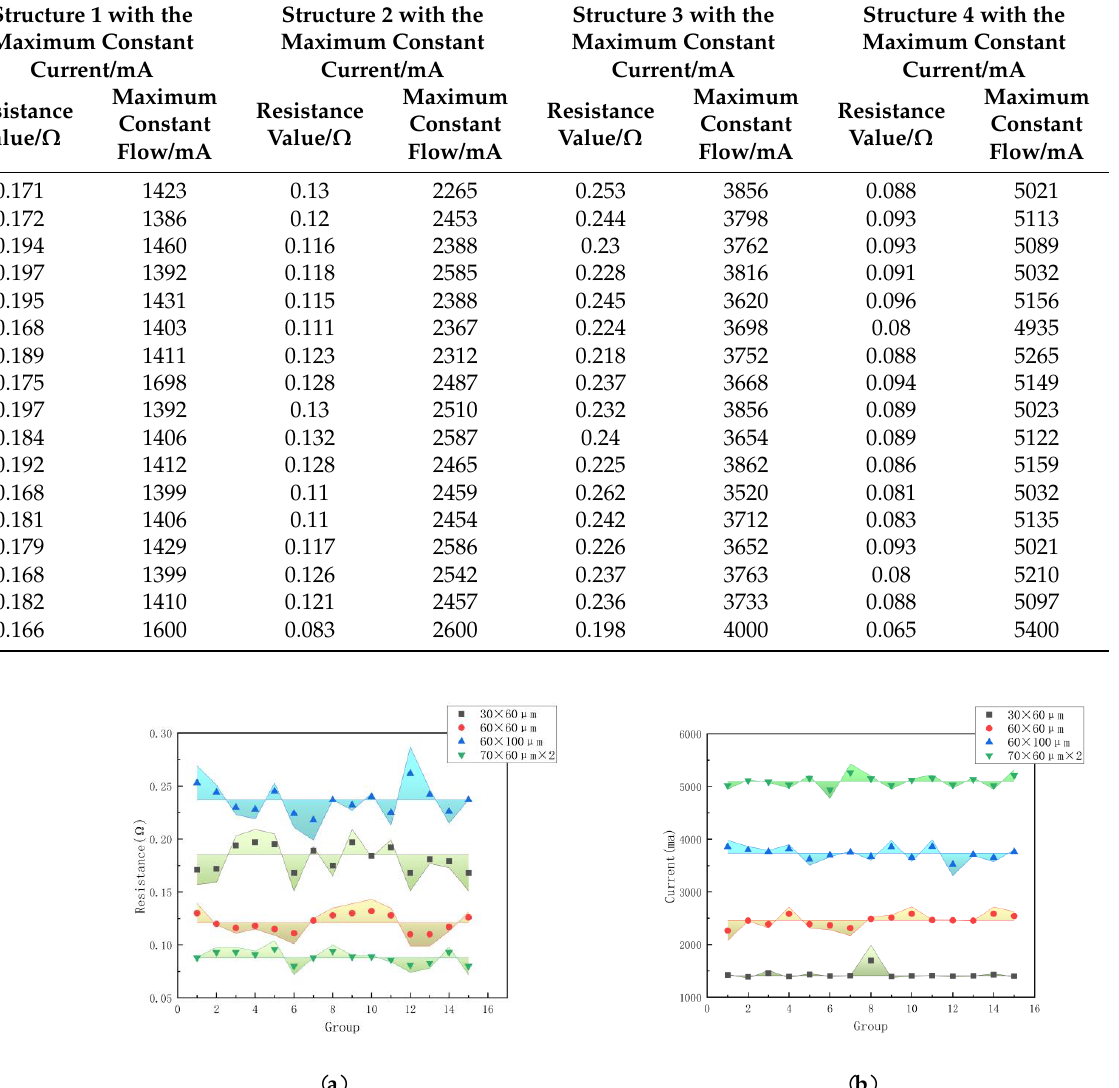
Figure 16. ( a ) Resistance error analysis. ( b ) Current error